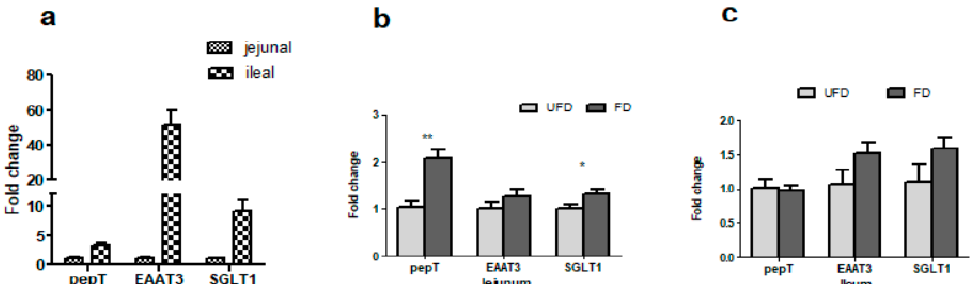
Figure 2. Relative gene expression of nutrient transport peptide genes in porcine jejunum and ileum ( a ) and effects of fermented feedstuff (FFS) on the expression of the two genes in the jejunum ( b ) and ileum ( c ) of weaned piglets. The mRNA expression was measured by real-time PCR with 5 mg of total mRNA. Glyceraldehyde 3-phosphate dehydrogenase (GAPDH) and tyrosine 3-monooxy- genase/tryptophan 5-monooxygenase activation protein zeta polypeptide (YWHAZ) were used as reference genes, and the geometric mean of their Ct value was used as an internal control. The re- sults of the feed change are shown as mean ± S.E.M. EAAT3: excitatory amino acid transporter3; PepT1: peptide transporter 1; SGLT1: sodium–glucose linked transporter 1; UFD: unfermented feed group; FD: fermented group. Bars with one star denote a significant difference ( p < 0.05). Bars with two stars mean very significantly different (p < 0.01).